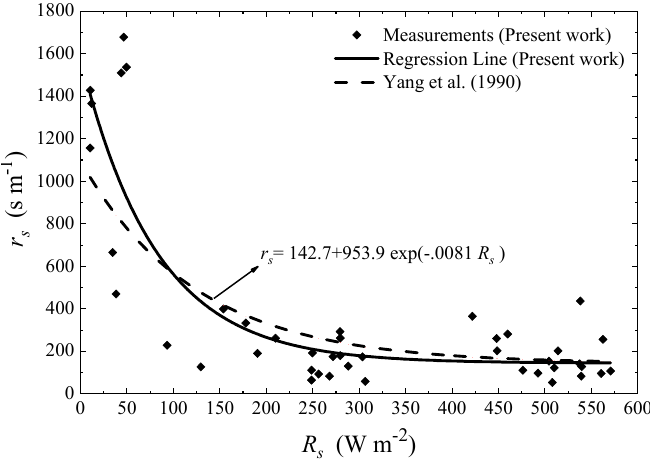
Figure 4. Evolution of plant height ( H ) and leaf area index (LAI) during cucumber growth in 2017 ( a ) and 2018 ( b ). The transplanting and harvesting dates were 3 September and 12 December in 2017, respectively, and 23 March and 29 June in 2018, respectively.